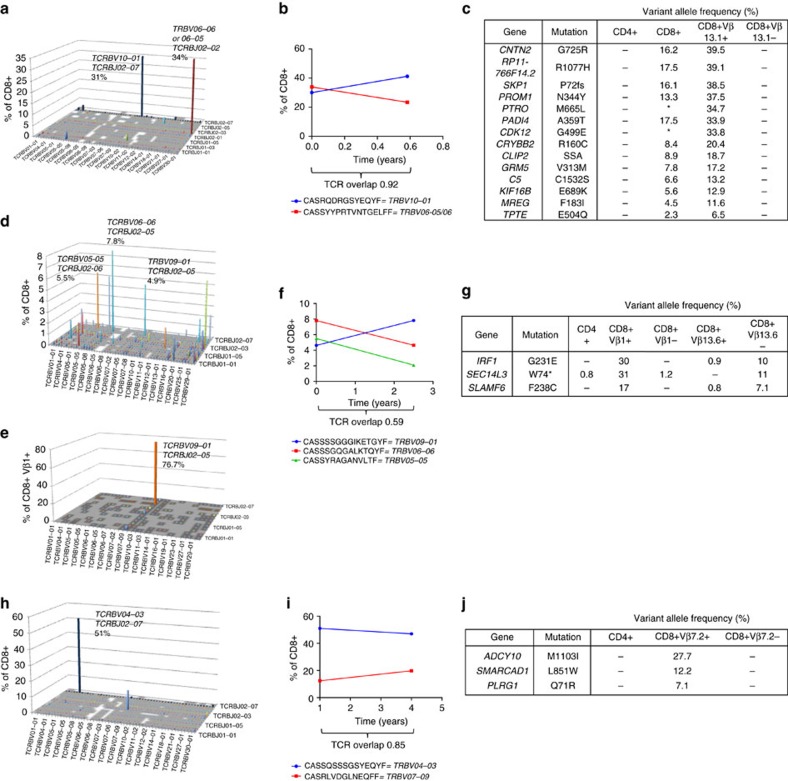
Somatic mutations occur in expanded CD8+ T-cell clones that persist during follow-up.(a) The figure shows the CD8+ clonal architecture of patient 1, on the basis of TCRB sequencing and V-J genes. The Vβ13.1+ population detected by flow cytometry corresponded to clones using TCRBV06-05, 06-06, or 06-09 genes. (b) TCRB sequencing showed that patient 1 harboured two very large CD8+ T-cell clones. The two expanded clones of patient 1 persisted at a similar level during follow-up. The amino-acid TCRB sequences and the V genes of these unique clones are shown in the figure. (c) Amplicon sequencing of FACS-sorted cell fractions confirmed the identified mutations. The table presents the VAFs in each cell fraction. (d) The clonal architecture of patient 2's CD8+ pool as shown via V and J genes. Clones using TCRBV09-01 correspond to Vβ1+ antibody in flow cytometry. (e) Similarly presented TCRB sequencing results of flow-sorted Vβ1+ cells. When examining unique clones (‘unique’ defined by a unique nucleotide sequence) the largest clone composed 73% of all CD8+ Vβ1+ cells. (f) Patient 2 harboured several unique CD8+ T-cell clones at diagnosis. The TCRBV09-01 clone, in which mutations were observed, increased slightly during the follow-up. Amino-acid sequences derived from these unique clones are shown. The clone using TCRBV09-01 in this panel had the exact same nucleotide TCRB sequence as the largest clone in sorted Vβ1+ cells. (g) Amplicon sequencing results on FACS-sorted cells show the VAFs in each cell fraction. The low (<1%) VAFs found in CD4+ and Vβ13.6+ cells are considered sorting impurities, and thus the mutations in patient 2 occur exclusively in CD8+Vβ1+ cells. The mutation VAFs in CD8+Vβ1+ cells correspond well with the TCRBV09-01 clone size in sorted cells (h) The clonal landscape of CD8+ cells from patient 3. Clones using TCRBV04-03 gene correspond to Vβ7.2 usage in flow cytometry. (i) Patient 3 harboured a very large CD8+ T-cell clone at diagnosis, which persisted at a similar level during follow-up. (j) Amplicon sequencing of flow-sorted cell populations showed that the mutations detected in exome sequencing exist only in Vβ7.2 CD8+ T cells and not in other T cells.